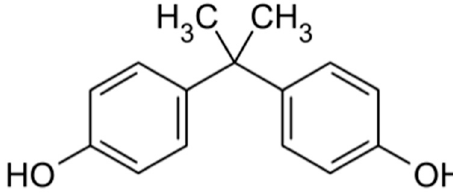
Figure 4. Chemical structure of BPA.